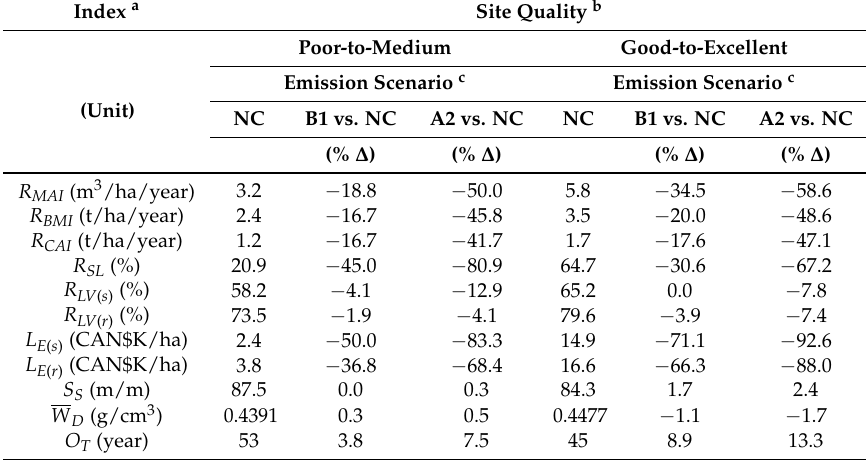
a–c : As defined in Table 3a table notes. Table 4b. Stand-level performance indices for jack pine plantations managed under a basic silvicultural intensity in north-central Ontario by emission scenario and site quality.